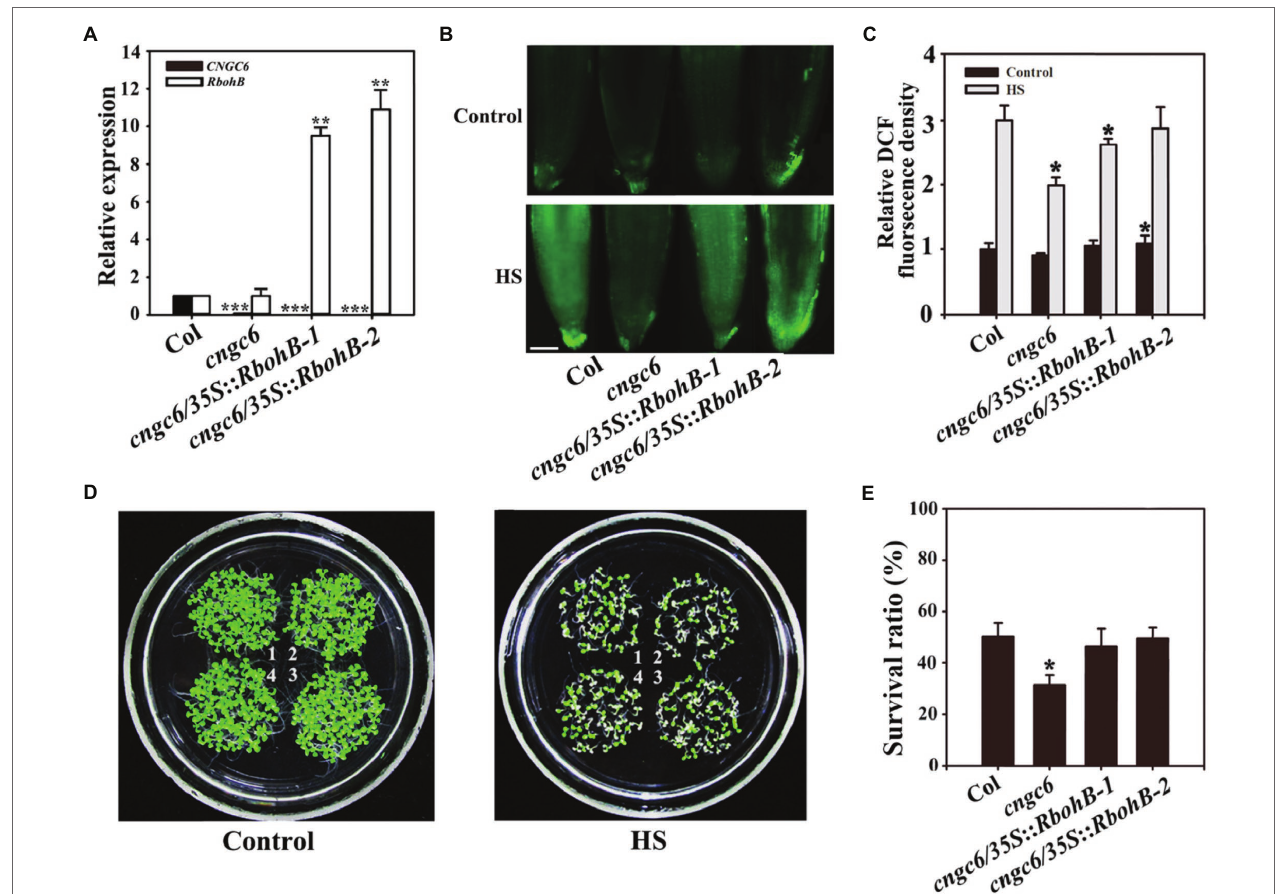
FIGURE 3 | Improved thermotolerance through AtRbohB overexpression in a cngc6 background. (A) Real-time quantitative PCR (RT-qPCR) analysis of AtCNGC6 and AtRbohB transcription in wild-type, cngc6 , cngc6 / 35S :: RbohB-1 , and cngc6 / 35S :: RbohB-2 plants. The experiments were repeated three times with similar results. Each data point represents the mean ± SD ( n = 3). Asterisks indicate a significant difference relative to Col (Student’s t -test: ** p < 0.01 and *** p < 0.001). (B) About 8-day-old wild-type, cngc6 , cngc6 / 35S :: RbohB-1 , and cngc6 / 35S :: RbohB-2 seedlings grown at 22 ° C were exposed to 45 ° C (HS) or maintained at 22 ° C (Control) for 30 min. The H 2 O 2 levels in the plants were then examined by fluorescence microscopy using roots stained with CM-H 2 DCFDA. Bar = 100 μ m. (C) The relative DCF fluorescence densities in the roots. The data presented are the means ± SE of measurements taken from five independent experiments with at least 10 roots for each treatment. * p < 0.05 vs. Col. (D) Seedlings grown at 22 ° C were exposed to 45 ° C (HS) or maintained at 22 ° C (Control) for 100 min, then returned to 22 ° C and photographed 5 days later. The clusters are as follows: 1, wild-type; 2, cngc6 ; 3, cngc6 / 35S :: RbohB-1 ; and 4, cngc6 / 35S :: RbohB-2 . (E) Survival ratios of the seedlings after HS treatment. The data presented are the means ± SE of at least five independent experiments with 50 seedlings per experiment. * p < 0.05 vs. Col (Student’s t